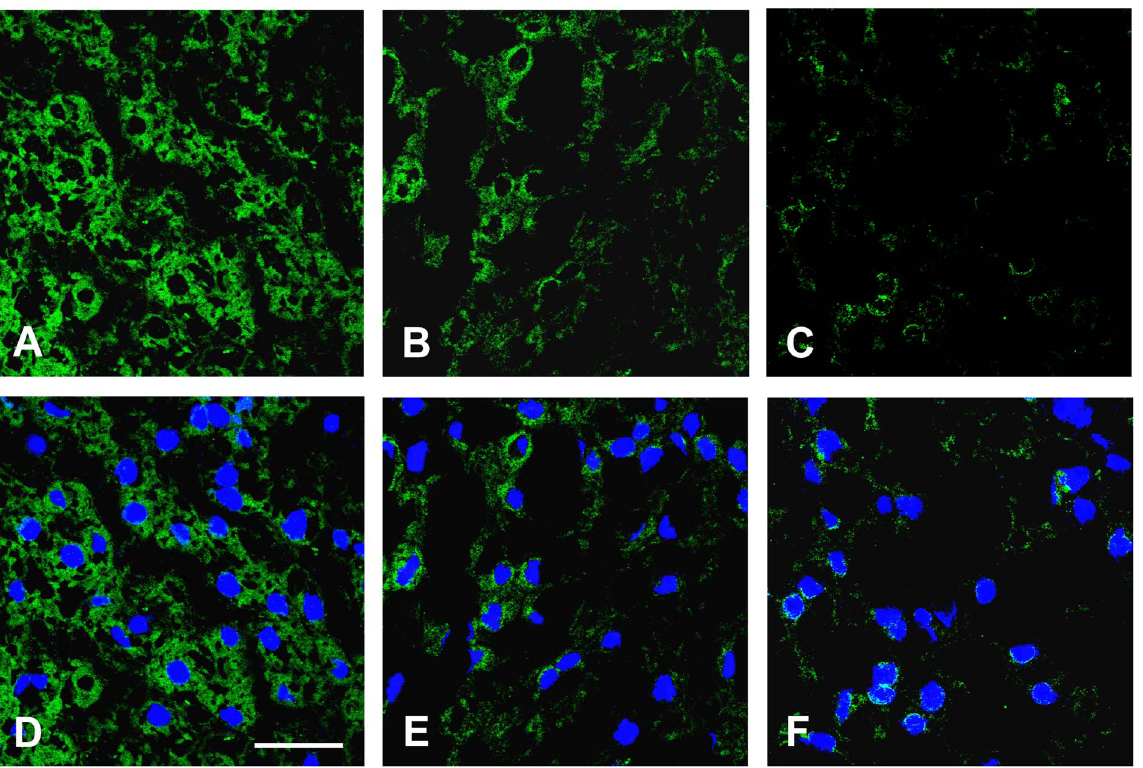
Figure 4. Representative confocal immunofluorescence for expression and intracellular distribution of Klotho co-receptor. The representative confocal immunofluorescence was performed on liver tissue cryostat sections OCT-embedded. The staining of Klotho co-receptor in the overweight-obese children without NAFLD ( A ), in the NAFLD overweight-obese children without NASH ( B ), and in the overweight-obese children with NASH (C) is shown in green. The nuclei are revealed by specific DAPI staining, displayed in blue. The white bar represents a 30 m m